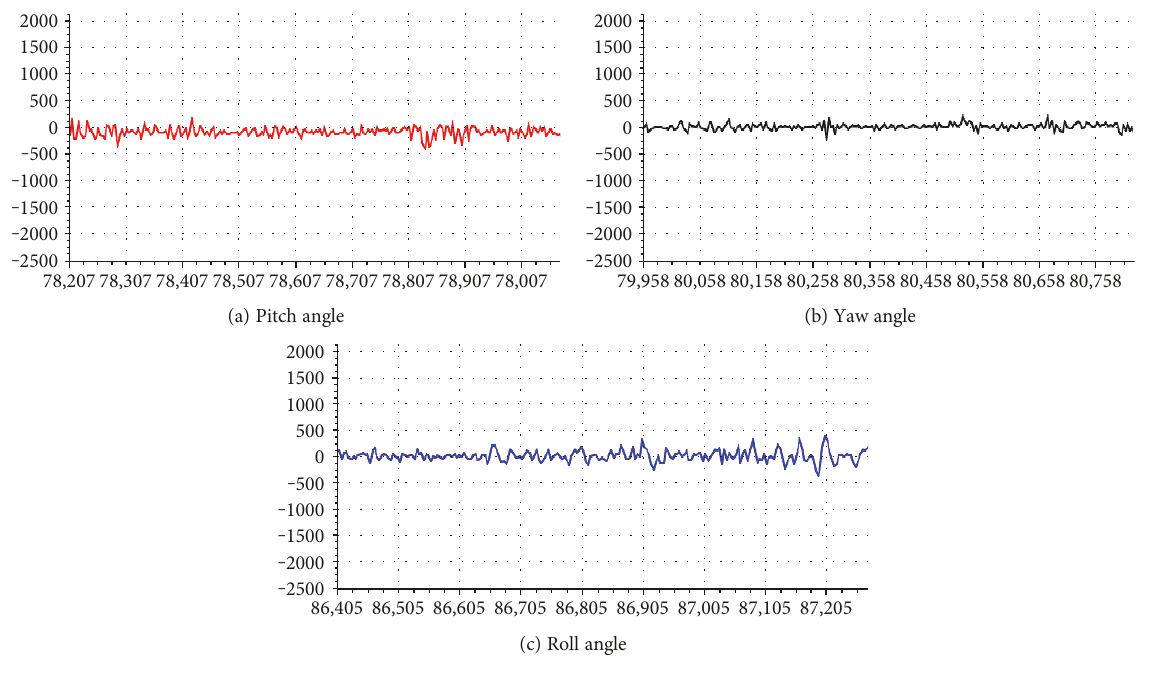
Figure 19: Flight attitude angle. Note: x -axis was time (t/s), and y -axis was angle ( ° /1000).